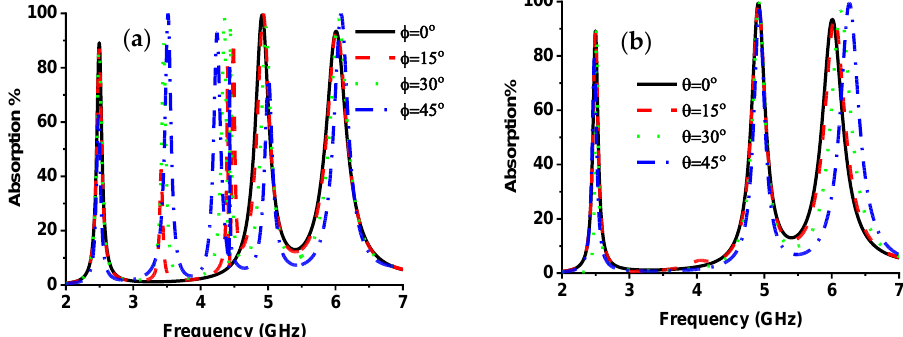
Figure 8. ( a ) Polarization incident angle (TE Mode) and ( b ) oblique incident angle (TE mode) of the proposed absorber.